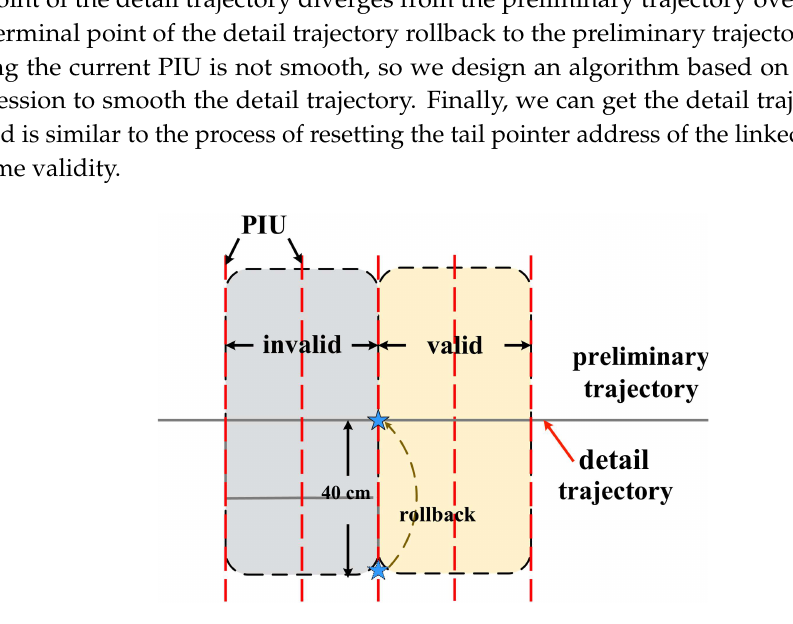
Figure 10. Trajectory detailing example. PIU, Path Information